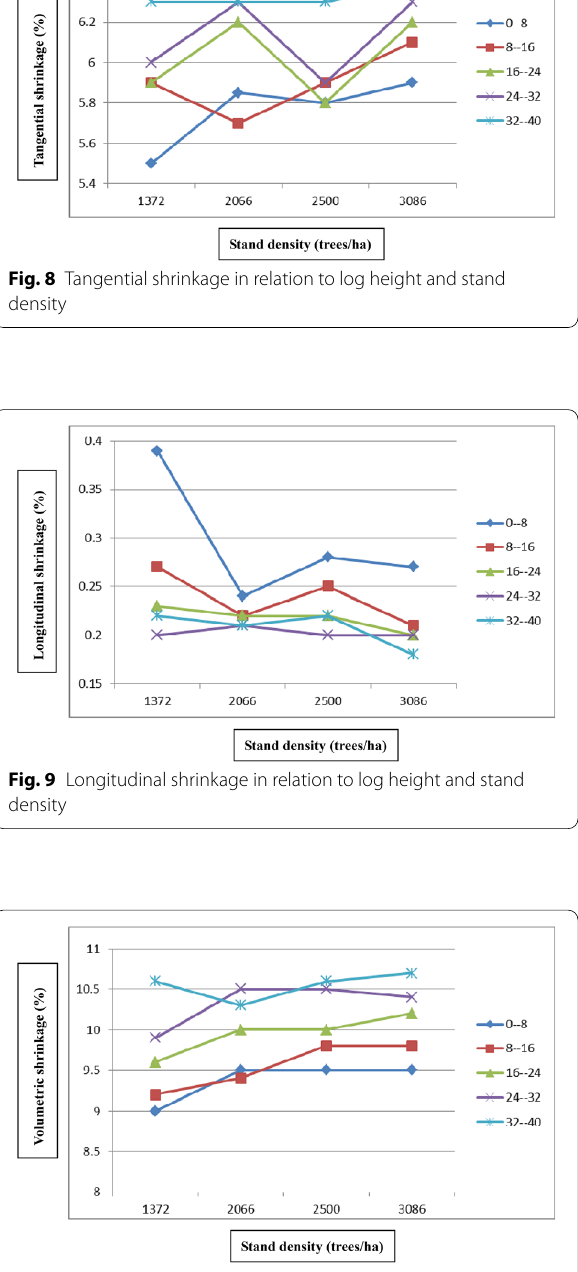
Fig. 10 Volumetric shrinkage in relation to log height and stand